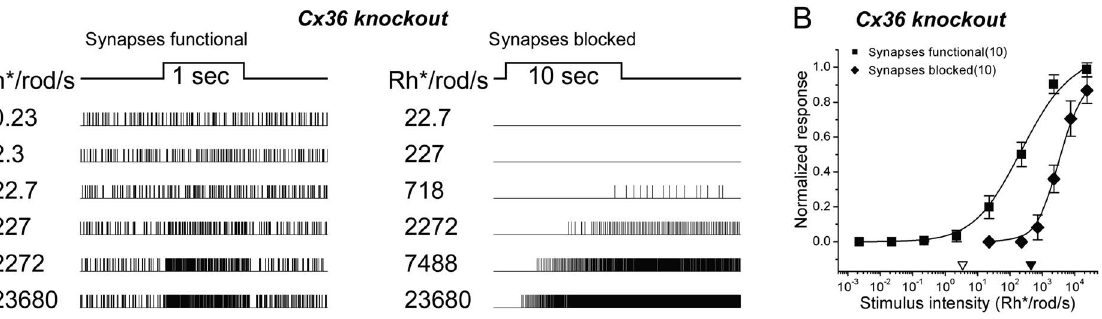
Figure 5. High-threshold light-evoked synaptic responses survive interruption of primary and secondary rod pathways by Cx36 knockout. A : Raster plots of light responses in a representative ipRGC from a Cx36 KO mouse recorded first with synapses functional (left) and then with synapses blocked (right). In synaptic blockade, the light response exhibited the long latency and prominent poststimulus persistence of spiking characteristic of melanopsin-mediated responses. With synaptic input intact (left), responses were brisker and more sensitive than the melanopsin- driven response. Because both primary and secondary rod ON pathways were disrupted by the genetic deletion of Cx36, these brisk, synaptically mediated responses were presumably driven by cones. Note that stimulus intensities are not matched in the left and right columns of panel A. Also, stimulus duration was increased 10-fold under synaptic blockade (right) because a 1 sec stimulus was too short to evoke an intrinsic photoresponse at most intensities tested. B : Group irradiance-response data of the sort illustrated in panel A for ten ipRGCs recorded from the same piece of Cx36 KO mouse retina. The triangles along the abscissa indicate the response thresholds (5% of maximum; open triangle, synapses functional; filled triangle, synapses blocked). The presumptive cone-driven response is at least 2 log units more sensitive than the melanopsin drive; the difference would have been greater if stimulus duration had not been increased under synaptic blockade to enhance the intrinsic response. Qualitatively similar results were obtained in a total of 8 retinas (data not shown).